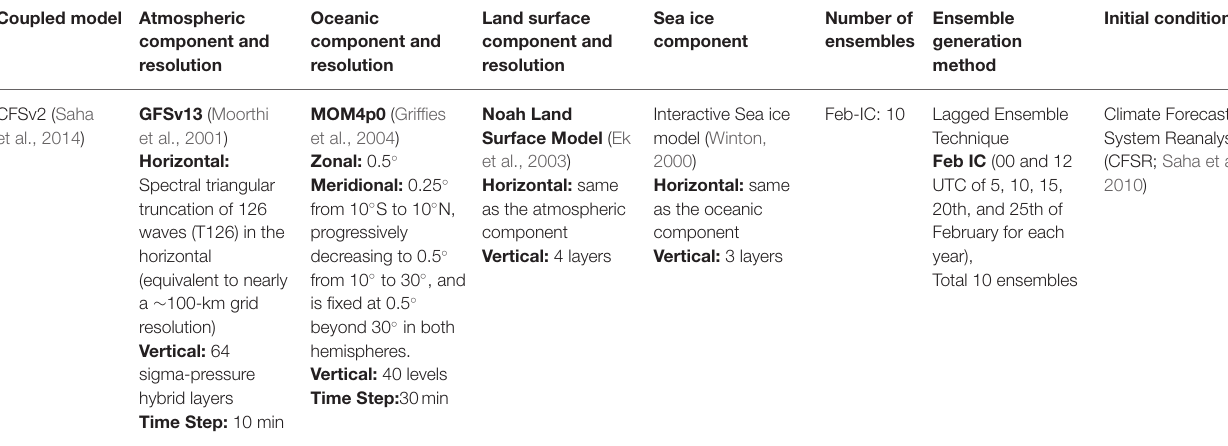
TABLE 1 | Description about model grid, resolution, and initialization of different components of CFSv2. Coupled model Atmospheric component and